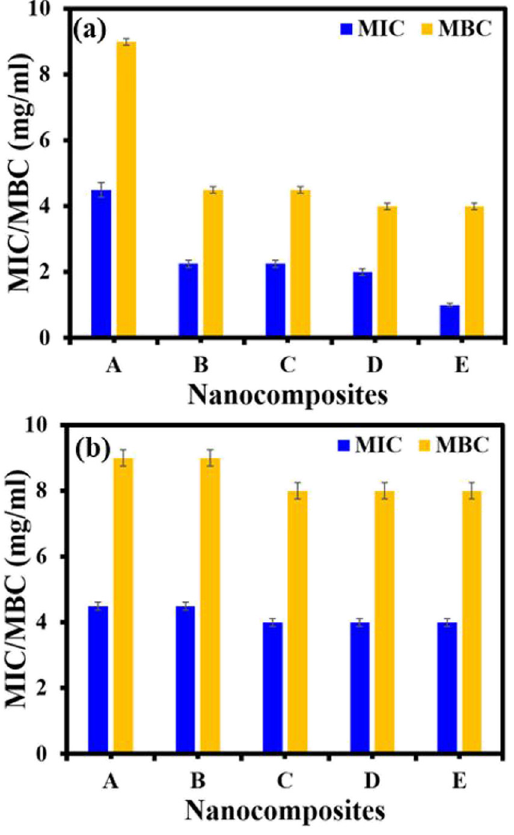
Figure 6: MIC and MBC ( mg/mL ) results of tested nanocomposites/ nanomaterials against ( a ) S. aureus and ( b ) P. aeruginosa ( A = g - C 3 N 4 , B = 2.5% - n - NiO@g - C 3 N 4 , C = 5% - n - NiO@g - C 3 N 4 , D = 10% - n - NiO@g - C 3 N 4 and E = 20% - n - NiO@g - C 3 N 4 )